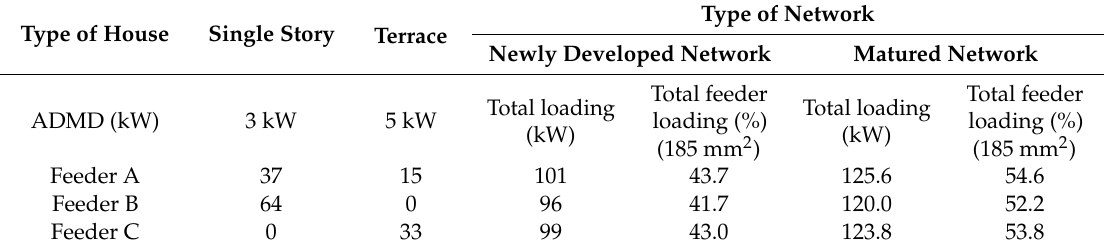
Table 2. Feeder loading